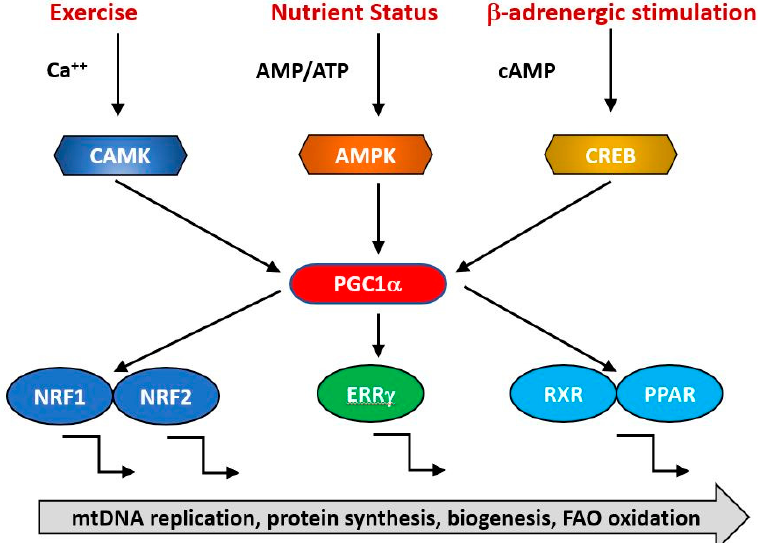
Figure 3. PGC1 α is a transcriptional co-factor that regulates the transcription of nuclearly encoded mitochondrial proteins by interacting with transcription factors such as Nrf1/2, ERRg and the PPAR family. It acts as a hub to integrate signals from several pathways that monitor the energetic and nutritional status of the cell, including AMP-activated protein kinase (AMPK), calcium/calmodulin - dependent protein kinase ( CAMK ) and cAMP-response element binding protein (CREB).